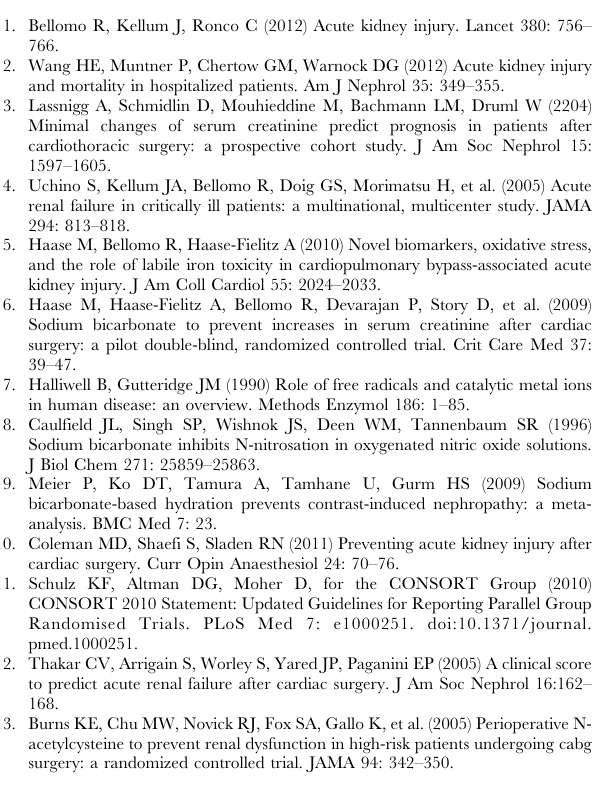
Table S3 Outcomes separated by study center. (DOC) Text S1 Trial protocol. (DOC) Text S2 CONSORT checklist [11].